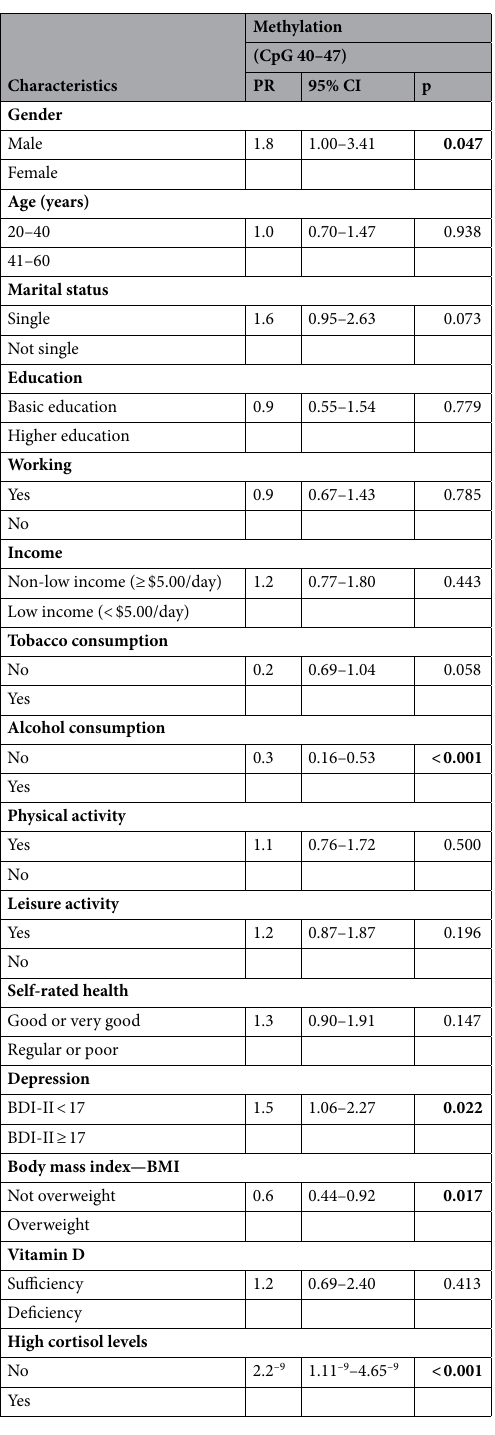
Table 3. Bivariate Poisson regression analysis with robust variance for NR3C1 1F region methylation. Bold values indicate significance result. PR prevalence ratio, 95% CI confidence interval, p p